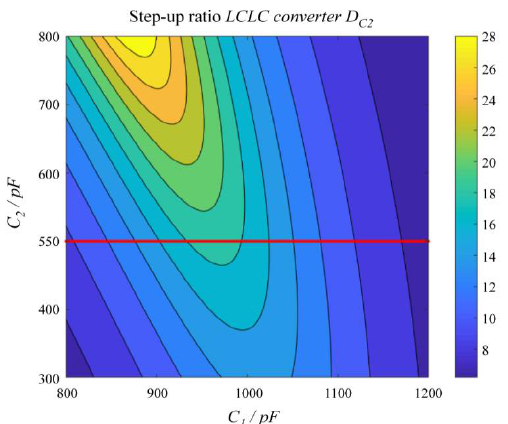
Figure 10. Effect of L1 and L2 on the step-up ratio D c2 .